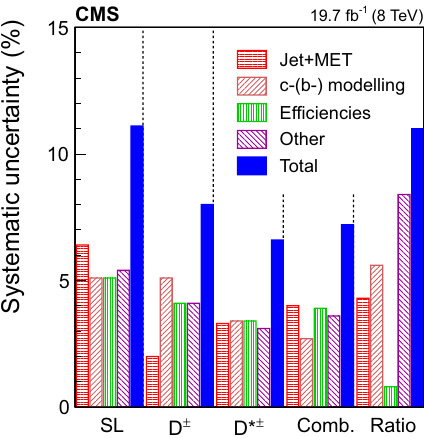
Fig. 10 Contributions to the systematic uncertainty in the measured Z + c cross section and in the ( Z + c )/( Z + b ) cross section ratio. The firstthreeblocksinthegraphshowtheuncertaintiesintheZ + ccrosssec- tion in the three decay modes, semileptonic (SL), D ± , and D ∗ ( 2010 ) ± , calculated from the combination of the dimuon and dielectron Z boson decay channels. The fourth block shows the systematic uncertainties in thecombined(Comb.)Z + ccrosssection.Thelastblockpresentsthesys- tematic uncertainty in the ( Z + c )/( Z + b ) cross section ratio measured in the semileptonic mode. For every block, the height of the hatched bars indicates the contribution from the different sources of systematic uncertainty. The last, solid bar shows their sum in quadrature